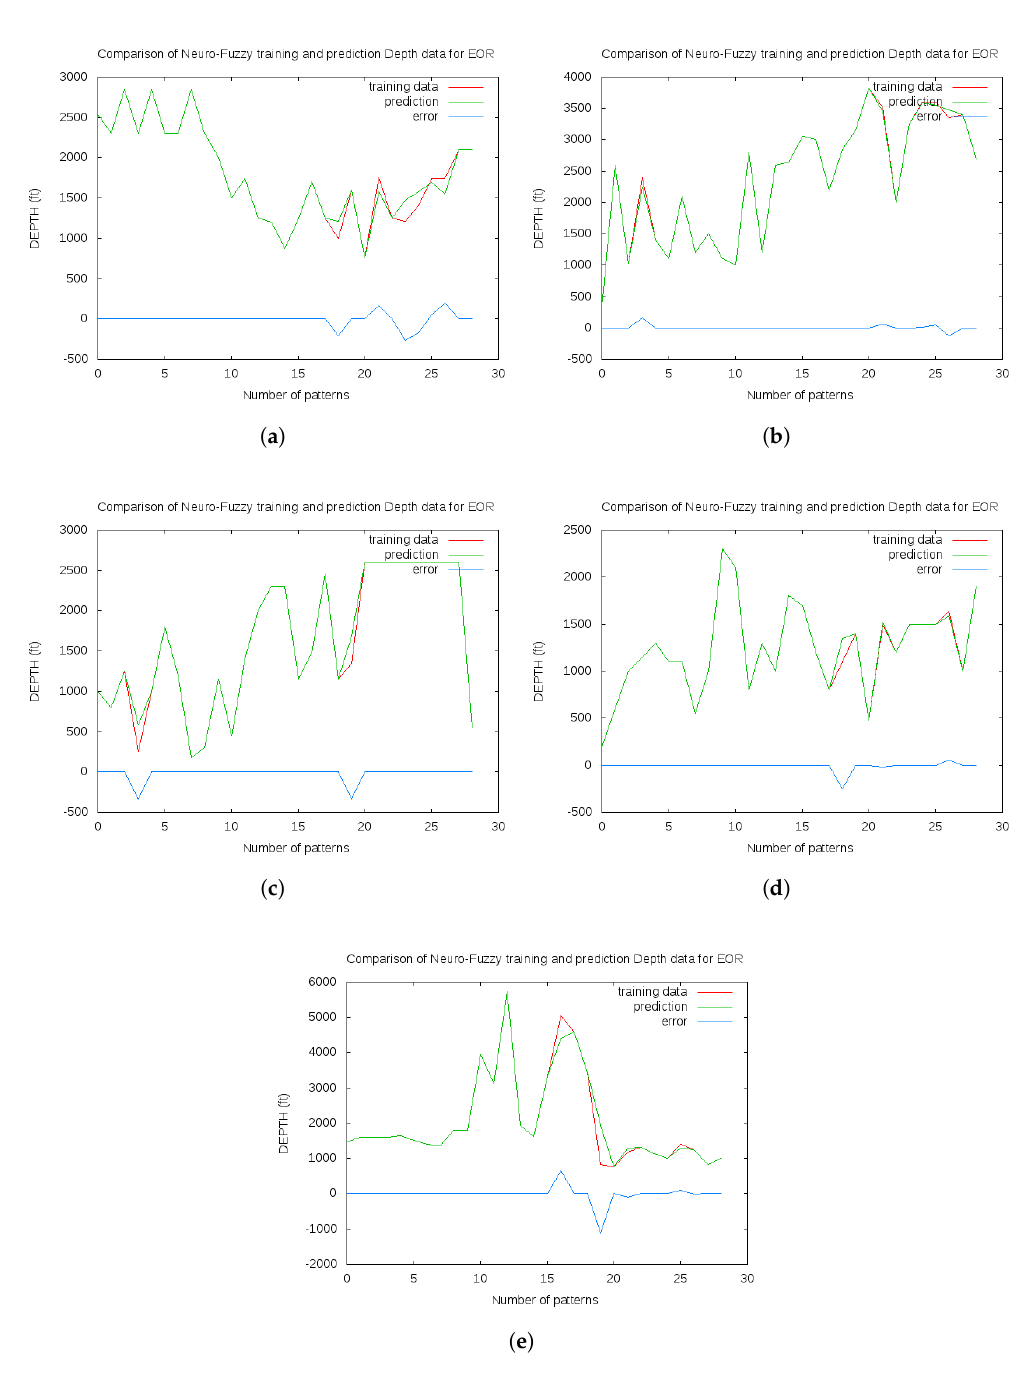
Figure 11. Plots of depth for the weighted training data, prediction data and associated error versus number of patterns for steam: ( a ) option 1; ( b ) option 2; ( c ) option 3l ( d ) option 4; and ( e ) option